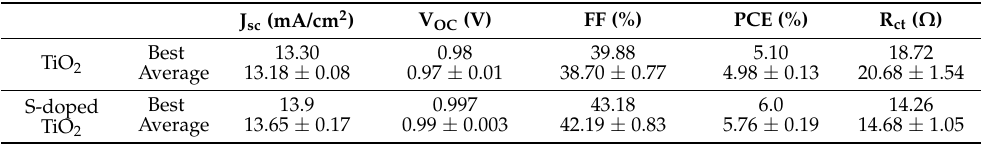
Table 1. Photovoltaic parameters derived from J-V measurements for perovskite solar cells device using S-doped TiO 2 and undoped TiO 2 with a 0.07 cm 2 active area. J sc (mA/cm 2 ) V OC (V) FF (%) PCE (%) R ct ( Ω ) Best 13.30 0.98 39.88 TiO 2